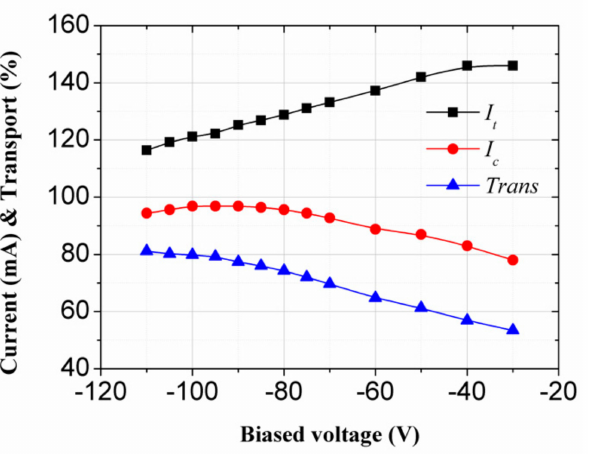
Figure 14. The measured current and the transport efficiency as a function of the biased focus voltage. Table 3 compared the beam parameters and the transport efficiencies of the sheet-